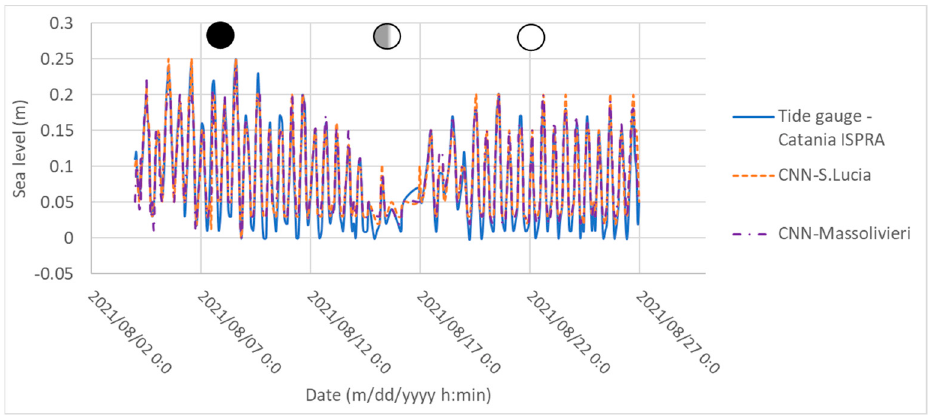
Figure 14. Tide gauge records of Catania (ISPRA) for August 2021 compared with the CNN prediction of S.Lucia and Massolivieri. Black and with circles represents the phases of spring tides, while gray half circle represents the phase of neap tide.